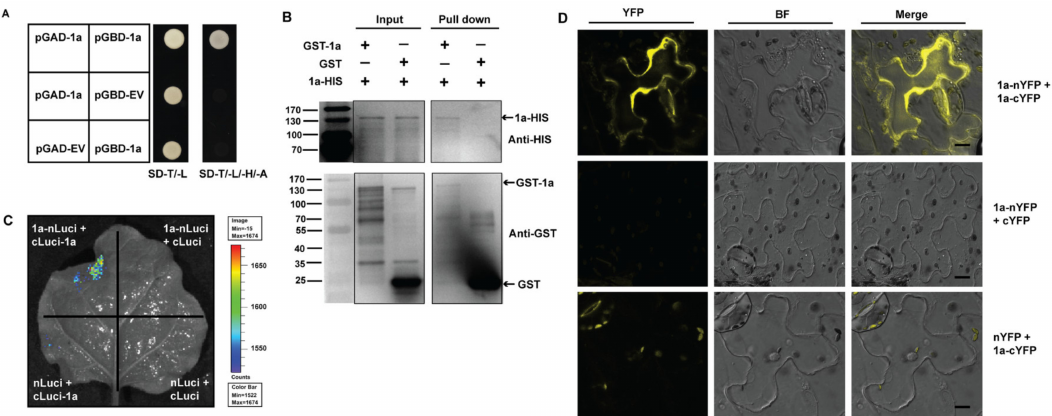
Figure 3. Self-intermolecular interactions of ApNMV 1a. (A ) The yeast-two-hybrid assay indicated the presenceof1a–1ainteractions. pGADandpGBDemptyvectors(EV)servedascontrols. ( B ) A pull-down assay also suggested the presence of 1a–1a interactions. The recombinant GST–1a and 1a–HIS proteins were mixed and incubated. The anti-GST and anti-HIS antibodies were used to detect the target proteins from both inputs and were pulled down. Molecular mass markers are shown and labeled (KDa) on the left side. GST–1a, GST, and 1a–HIS bands are indicated by arrows on the right side. ( C ) A luciferase complementation imaging assay verified 1a–1a interactions. The bar on the right side represents the intensity of the signals captured. The empty nLuci and cLuci vectors served as controls. ( D ) The bimolecular fluorescence complementation assay suggests that the 1a–1a interactions occurred in the cytoplasm of epidermal cells of N. benthamiana leaves. nYFP and cYFP empty vectors served as controls. BF, bright field; Scale bar, 10 µ m. All images in Figure 3D were obtained in a single optical